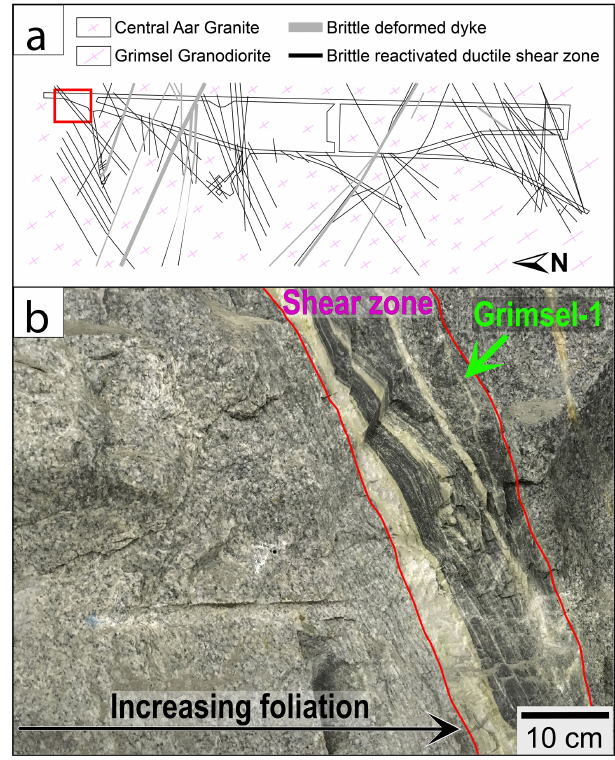
Figure 2. (a) Geological map of the Grimsel test site (GTS) of Na- gra with the location of (b) shown in the red rectangle (redrawn from Schneeberger et al., 2019). (b) Field photograph of the loca- tion of the studied epidote–quartz vein (Grimsel-1) and the steeply NNW-dipping Alpine shear zone with which it is associated; both are in the Central Aar Granite, which shows increasing foliation to- wards the shear zone (modified from Peverelli et al., 2022).